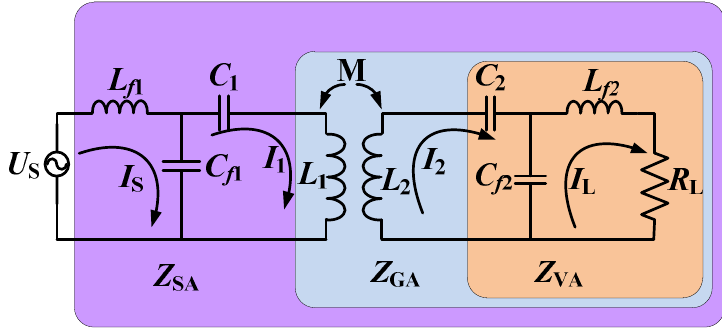
Figure 3. LCC-LCC compensation network topology.